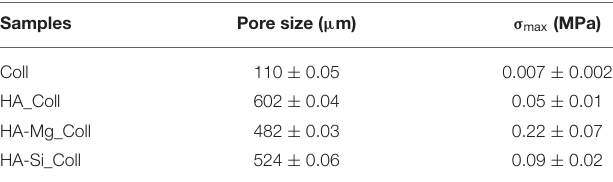
TABLE 1 | Pore size and maxim stress at failure of collagen and composite scaffolds.